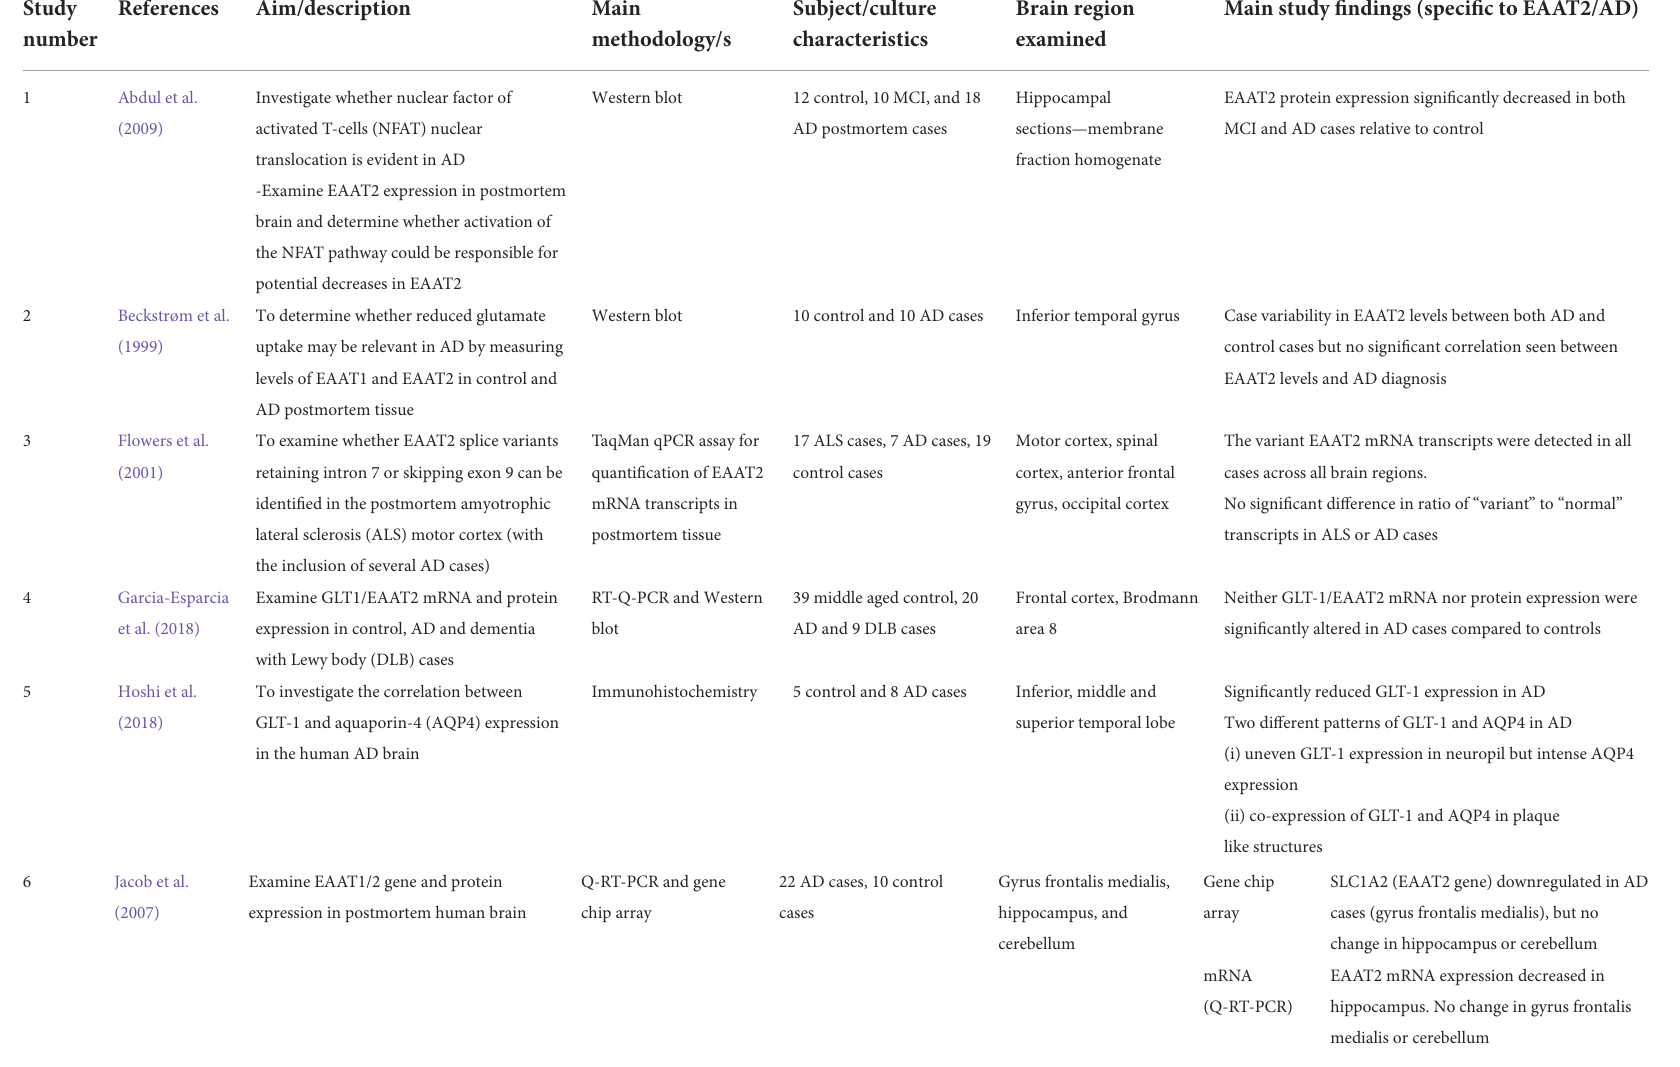
TABLE 1 Summary of human postmortem EAAT2 studies included in this systematic